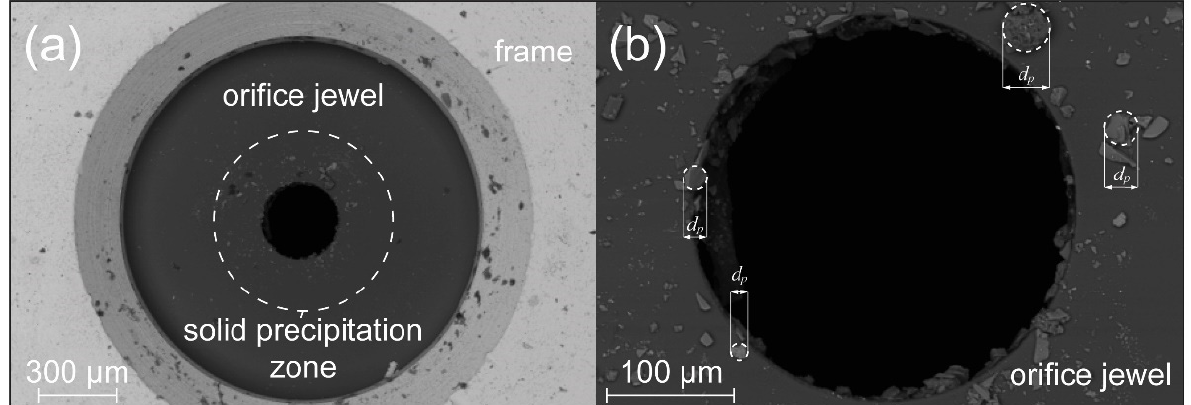
Figure 8. SEM images of a type 91 sapphire orifice after 35 min of operation at an operating pressure of 300 MPa and 133 switching operations: ( a ) overview demonstrating preferred precipitation around the orifice bore and ( b ) high magnification image used to estimate particle size distribution with some exemplary markings of particle diameters.